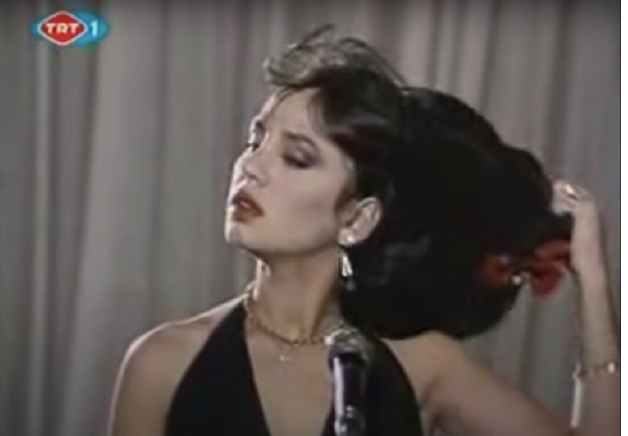
Figure 1: Hülya gets tired of imitating